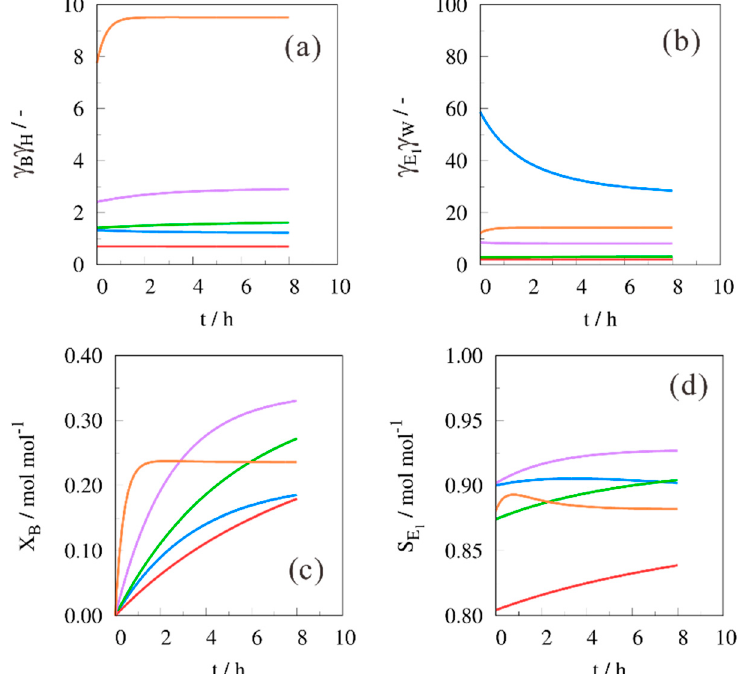
*W , present in reaction rate expression 1 with ( B / H ) = 2 mol·mol − 1 , T 1 0